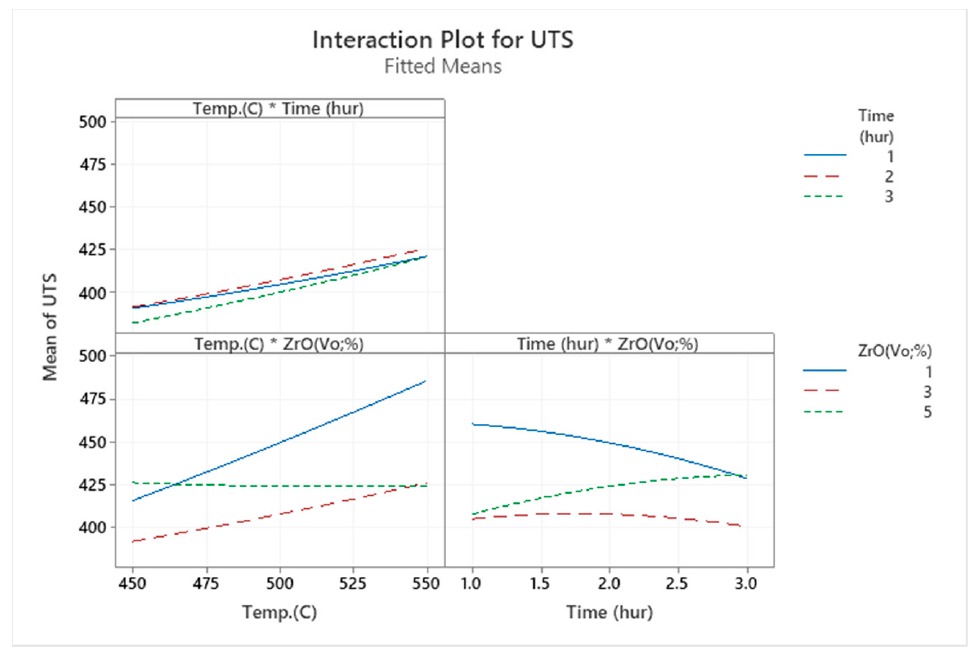
Figure 8. The interaction plot for UTS.